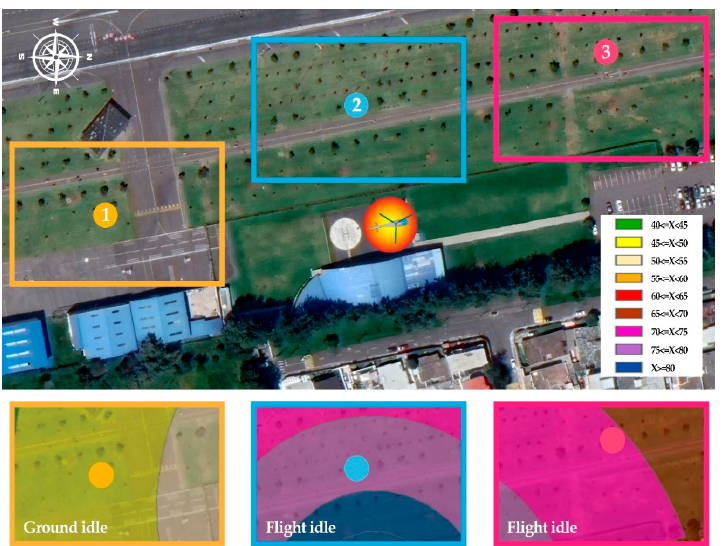
Figure 1. Study areas (L1, L2, and L3), sound source location, and predicted noise levels at two operational conditions.